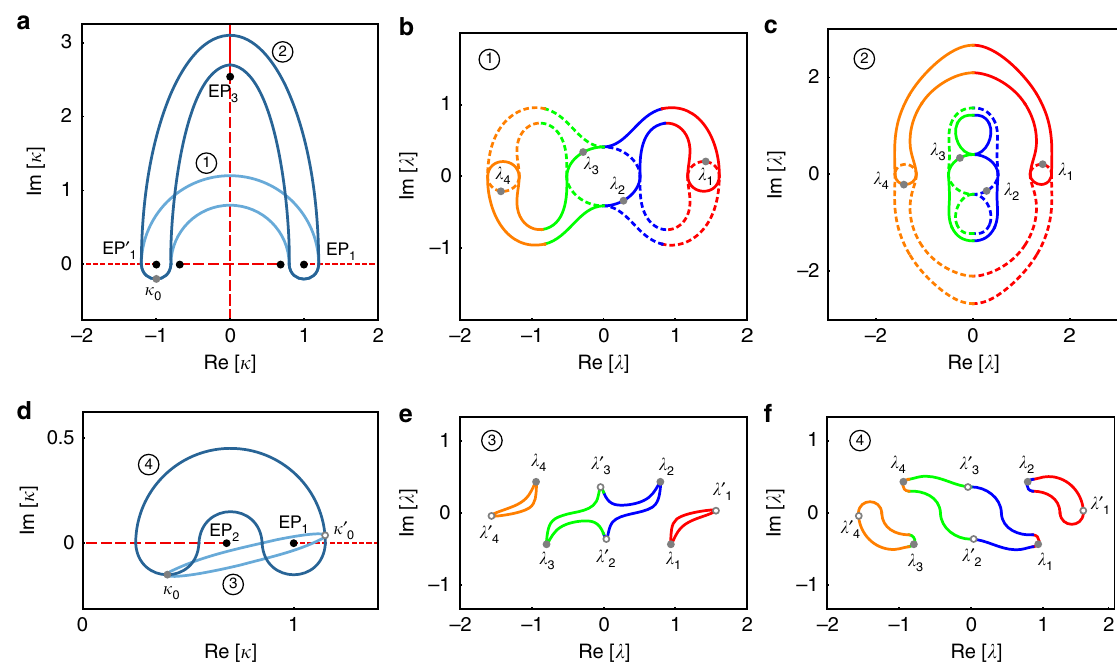
Fig. 5 Numerical example of homotopic relations between loops. a Two similar loops (cid:5) 1 and (cid:5) 2 encircle the exceptional points EP 1 and EP' 1 . The two loops are non-homotopic for any starting point including κ 0 (gray point) (which is considered for the example), since they cannot be deformed into one another without crossing EP 3 . Their corresponding matrix product is M 1 M 2 M 1 M 2 and I , respectively. This is con fi rmed by their eigenvalue trajectories as shown in b and c . d The two similar loops (cid:5) 3 and (cid:5) 4 are non-homotopic for the starting point κ 0 but homotopic for κ ' 0 . This is also re fl ected in the exchange relations of the eigenvalues as shown in e and f . Black dots represent EPs, red lines are the BCs, and the blue loops are the encircling